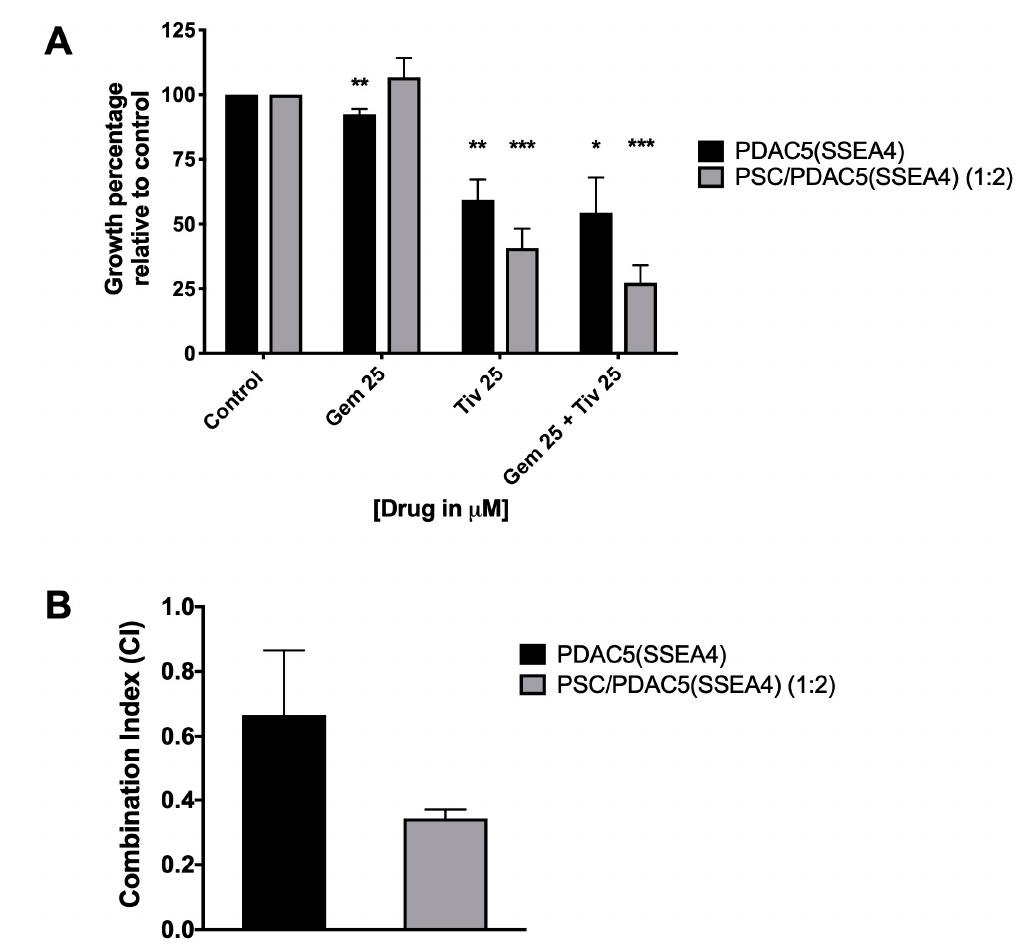
Figure 7. E ff ect of combination therapy on homo-spheroids [primary PDAC5 cells sorted for SSEA4 (PDAC5 (SSEA4)] and hetero-spheroids [PSC / PDAC5 (SSEA4)] cultures. The homo- and hetero-spheroids were formed as described in the methods. The 3D cultures were then treated either with gemcitabine or tivantinib or a combination of the two drugs for 3 days. The number of viable PDAC5 (SSEA4) cells were determined in spheroids by luciferase assay and were compared to their respective untreated controls. The data represent the mean ± standard error of mean (S.E.M.) of two to four experiments (*, ** and ***: the di ff erence between drug treated and untreated spheroid was significantly di ff erent at p < 0.05, p < 0.01 and p < 0.005, respectively) ( A ). Calculation of combination index (CI) with Calcusyn software showed synergism (CI < 0.9) between gemcitabine and tivantinib, especially in PDAC5 (SSEA4) cells ( B ). Abbreviations: PDAC, pancreatic ductal adenocarcinoma; SSEA4, stage specific embryonic antigen-4; PSC, pancreatic stellate